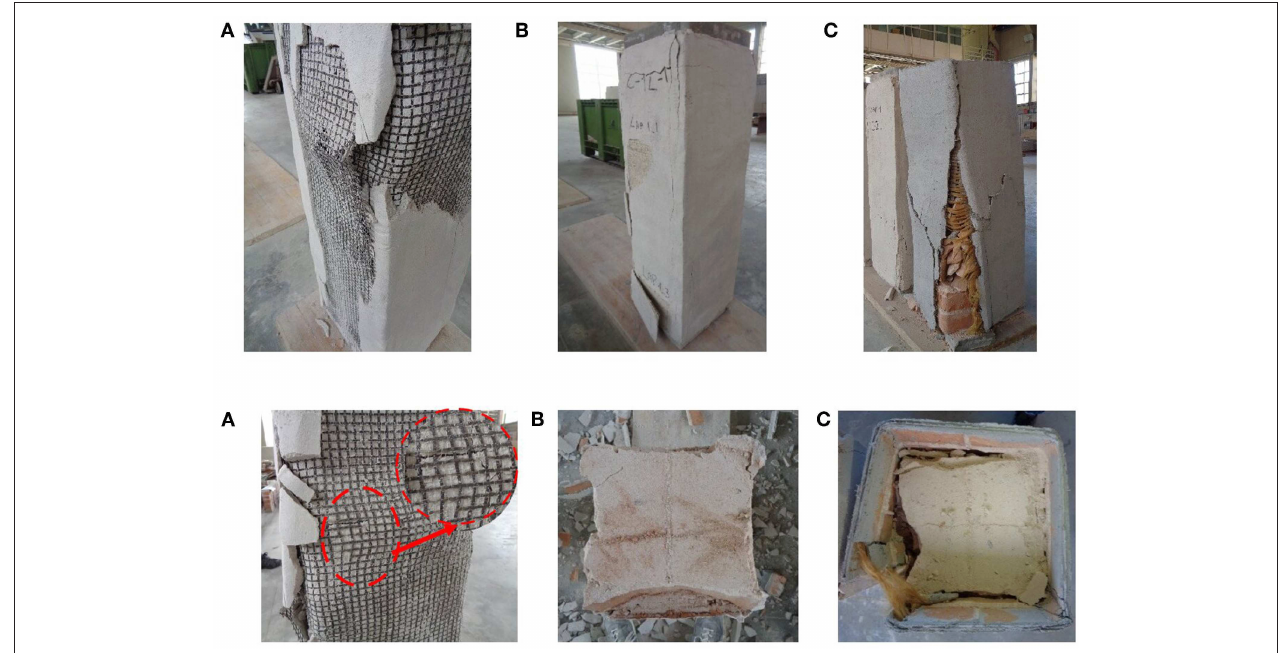
FIGURE 9 | Failure configurations for confined columns with: (A) Basalt-FRCM, (B) SRG (C-S-2), and (C) PBO-FRCM.